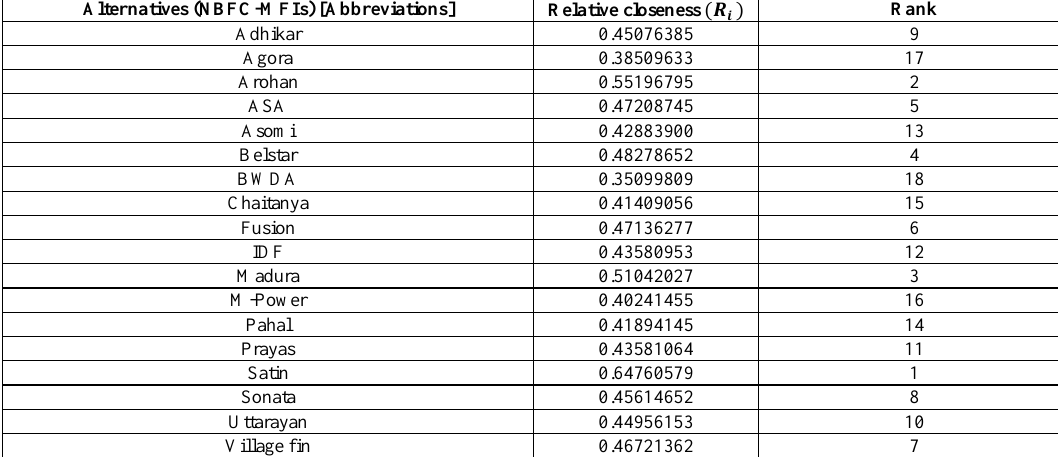
Table 4. Closeness coefficients and ranks of the alternatives for the combined period of 5 years (2014-15 to